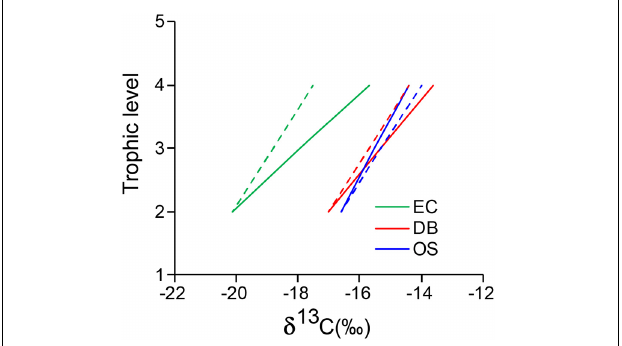
FIGURE 5 | The isotopic alignments from primary consumer to higher trophic level consumers showing, a positive deviation of observed δ 13 C values (solid lines) from the expected (dashed lines) values, indicating assimilation of δ 13 C-enriched coastal resources (DB and OS) in estuarine (EC)